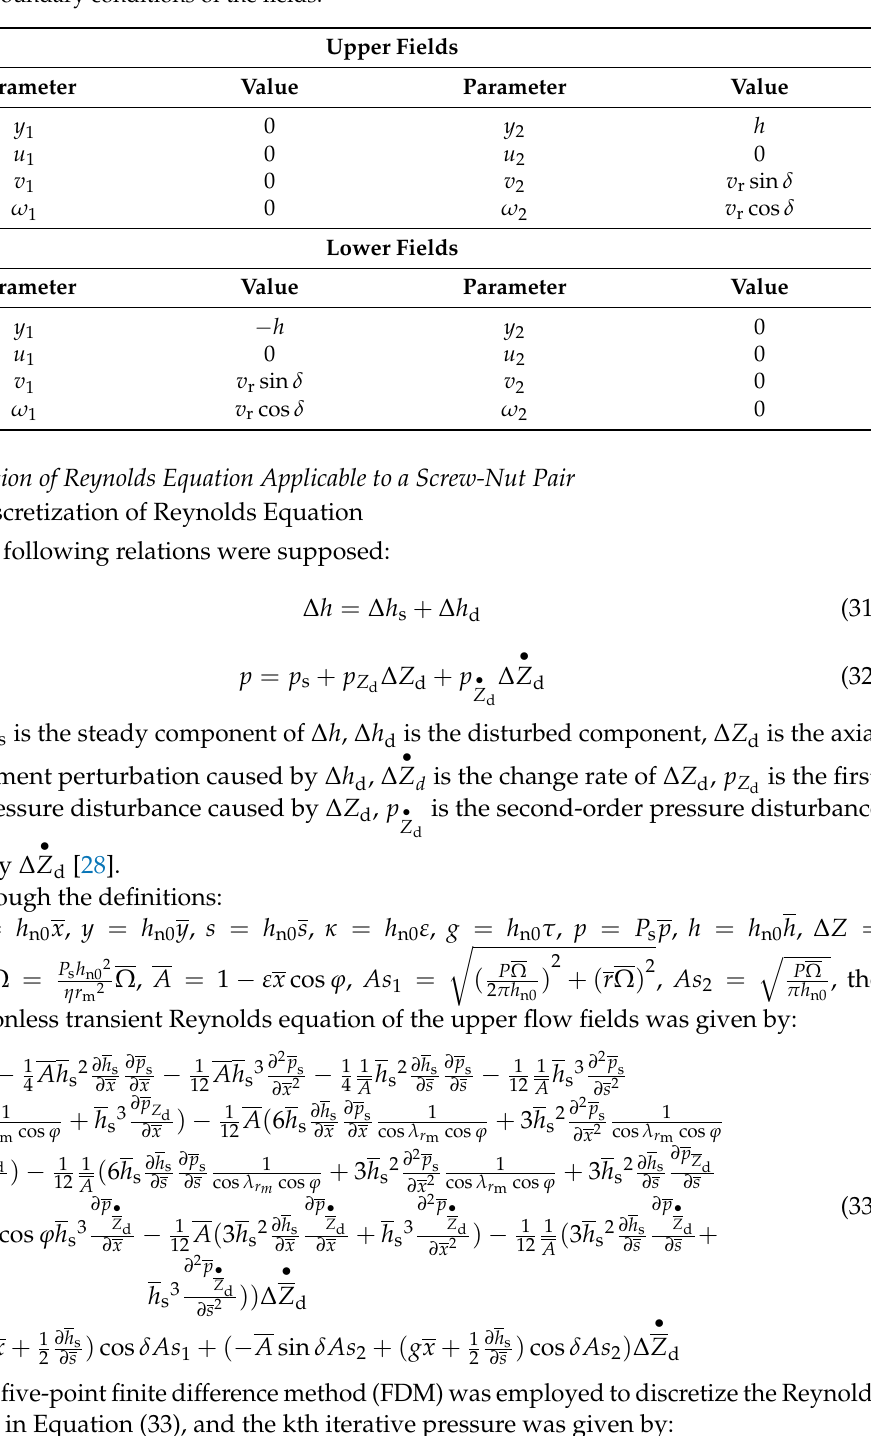
Table 1. Boundary conditions of the